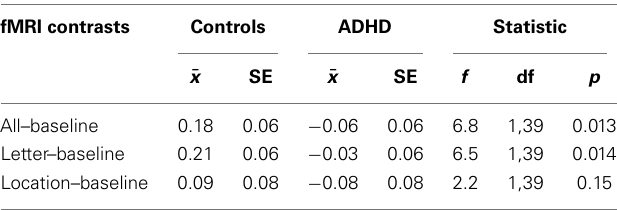
Table 4 | Group difference in adaptive-threshold based visual network asymmetry .